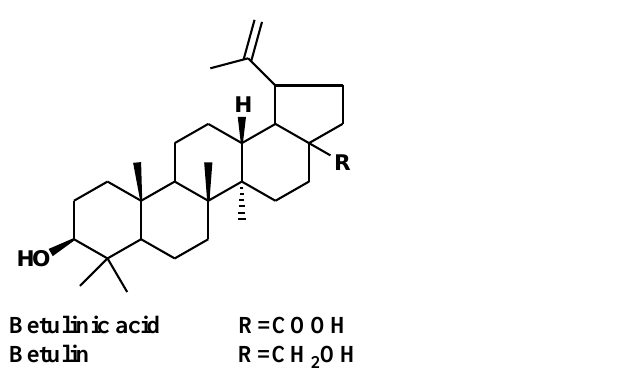
Figure 1. Structure of the two major compounds in the stem bark of Z. spina-christi L.